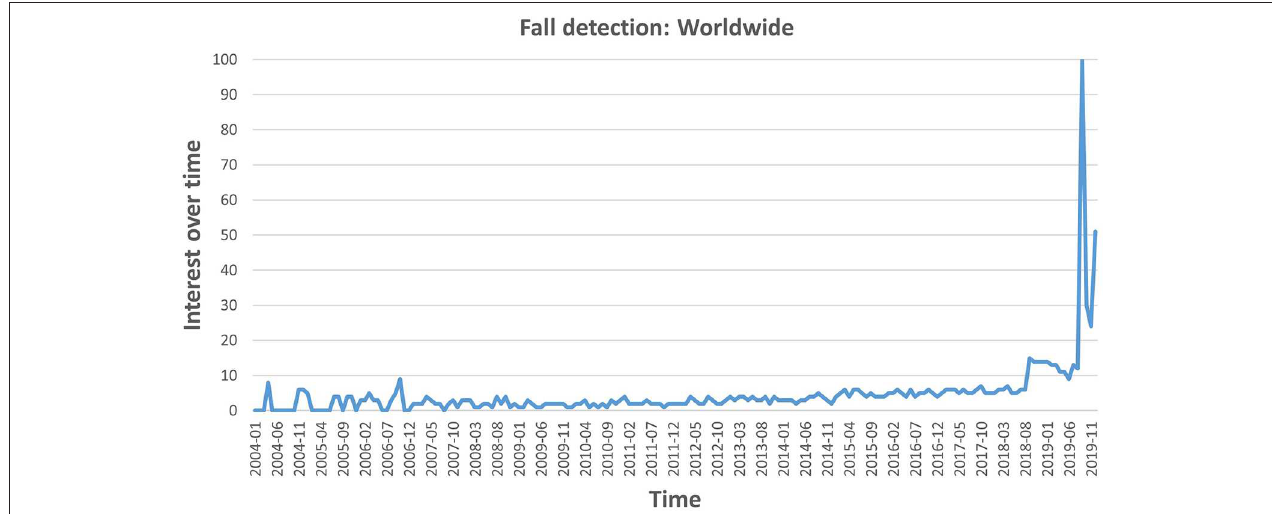
FIGURE 1 | Interest of fall detection over time, from January 2004 to December 2019. The data is taken from Google Trends with the search topic “fall detection.” The values are normalized with the maximum interest, such that the highest interest has a value of